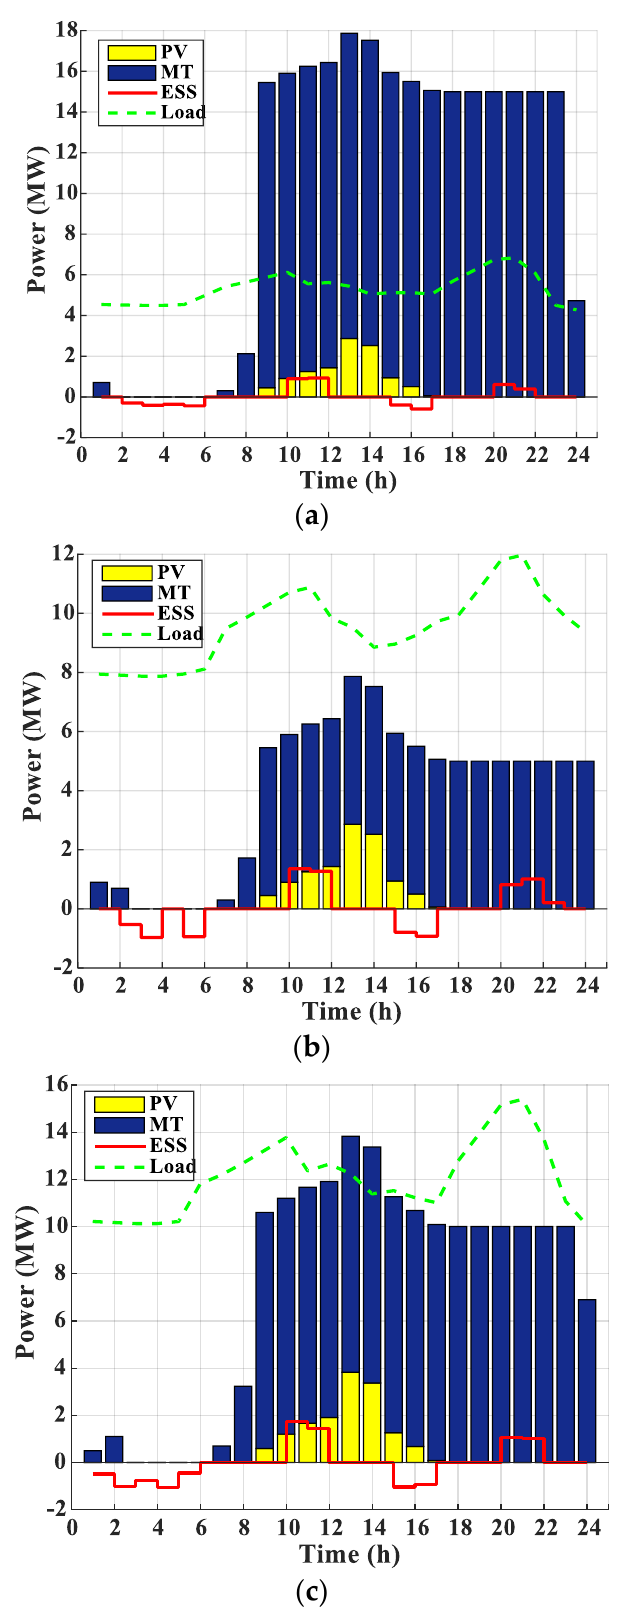
Figure 5. Optimal operation scheduling of distributed energy resources (DERs) for case study 1 in: ( a ) MG1; ( b ) MG2; ( c )